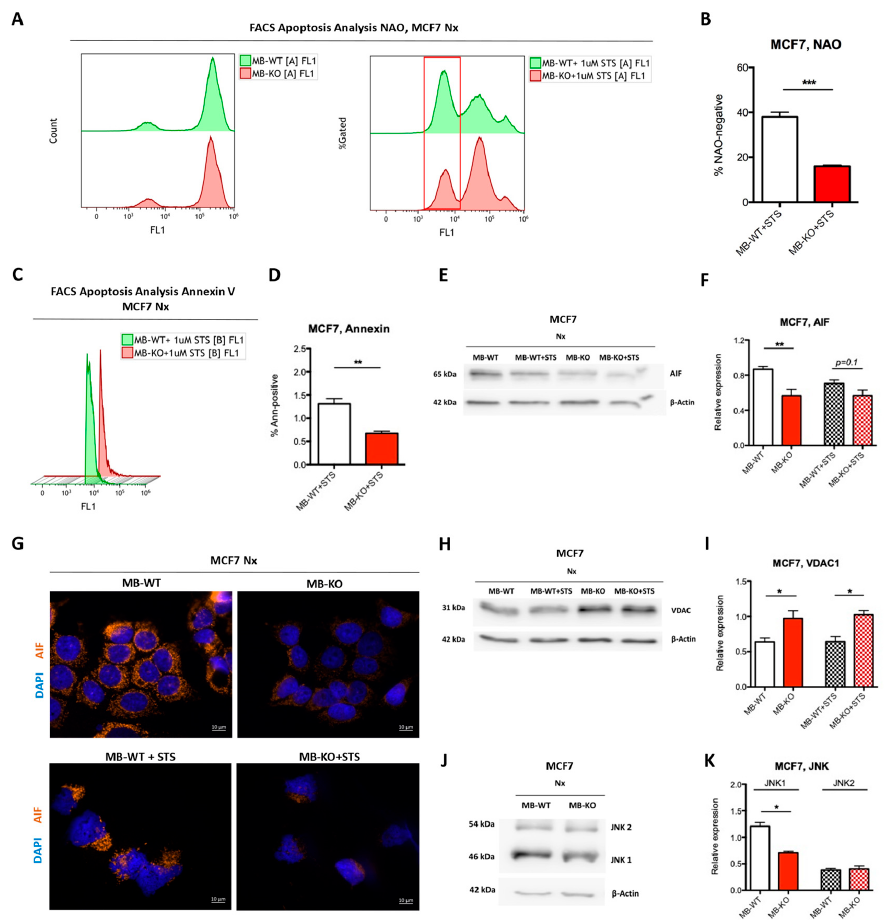
Figure 4. Myoglobin sensitizes breast cancer cells to apoptosis. ( A ) Representative FACS analysis of MB-WT and MB-KO clones of MCF7 cells stained by 10-N-Nonyl acridine orange (NAO), a fluorophore that forms a stable complex with the reduced form of cardiolipin within the inner mitochondrial membrane of living non-apoptotic cells. One hundred thousand cells were incubated, in duplicates, at Nx for 72 h, followed by incubation without (left panel) or with 1 mM of the apoptosis-inducing agent staurosporin (STS) for 6 h (right panel). The cell population with negative NAO fluorescence, marked with a red box, corresponds to the population of apoptotic cells. ( B ) Quantitative analysis of NAO-negative proportion of cells after with 1 mM of STS for 6 h ( n = 3). ( C ) Representative Annexin V staining-based FACS analysis of MCF7 cells, incubated in duplicates at Nx for 72 h, before treatment with 1 mM of the STS for 6 h, to detect cells at a later stage of apoptosis accompanied by live/dead stain of propidium iodide (PI). ( D ) Quantitative analysis of Annexin V-positive proportion of cells after with 1 mM of STS for 6 h ( n = 3). ( E , H ) Representative Western blotting image of whole tissue lysate of MB-WT and MB-KO clones of MCF7 cells cultured at normoxia (Nx) or 0.2% O 2 hypoxia (Hx) for 72 h and treated or not with 1 mM STS for 6 h, followed by staining for apoptosis-inducing factor (AIF) (65 kDa) ( E ) or VDAC1 (31 kDa) ( H ) and β -actin (42 kDa) used as the loading control ( n = 3). ( F , I ) Band intensity of AIF and VDAC1 proteins, respectively, after Western blotting, from MB-WT (white) and MB-KO cells (red) of MCF7 cultured at Nx without (empty bars) and with the treatment of 1 mM STS for 6 h (dashed bars), was quantified using MCID Analysis 7.0 and normalized to β -actin ( n = 3). ( G ) Representative immunocytochemistry images of MB-WT and MB-KO MCF7 cells stained for AIF (orange) and DAPI (blue) after culturing at Nx for 72h (upper panels) or with the treatment of 1 mM STS for 6 h (lower panels). Scale bar is 10 µm. ( J , K ) Representative Western blotting image and band intensity analysis of whole tissue lysate of MB-WT (white) and MB-KO (red) clones of MCF7 cells cultured at Nx for 72 h and stained for JNK1 (54 kDa), JNK2 (64 kDa) and β -actin (42 kDa) used as the loading control. Data are presented as the mean and standard error of mean and analyzed by Student’s t -test * p < 0.05; ** p < 0.01; *** p <